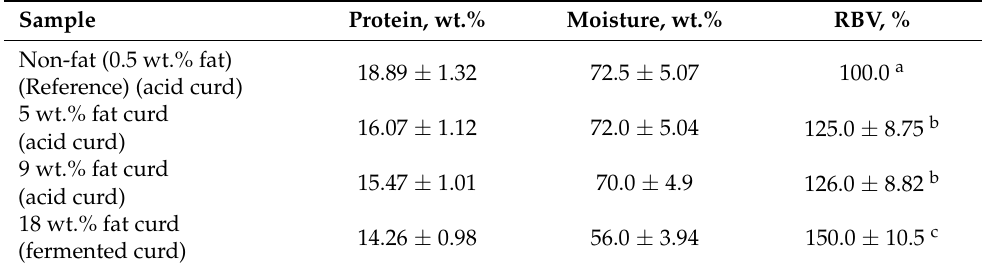
Table 6. Properties of curd samples with different fat content. a–c : Different superscript letters mark significant statistical difference between means of